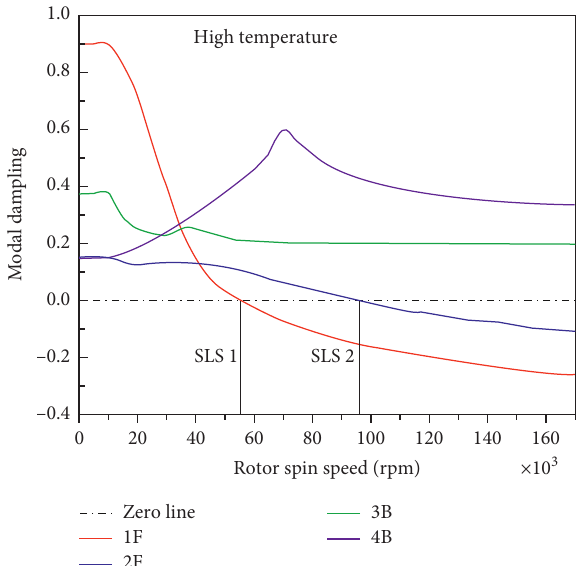
Figure 20: Effect of temperature on stability diagram.